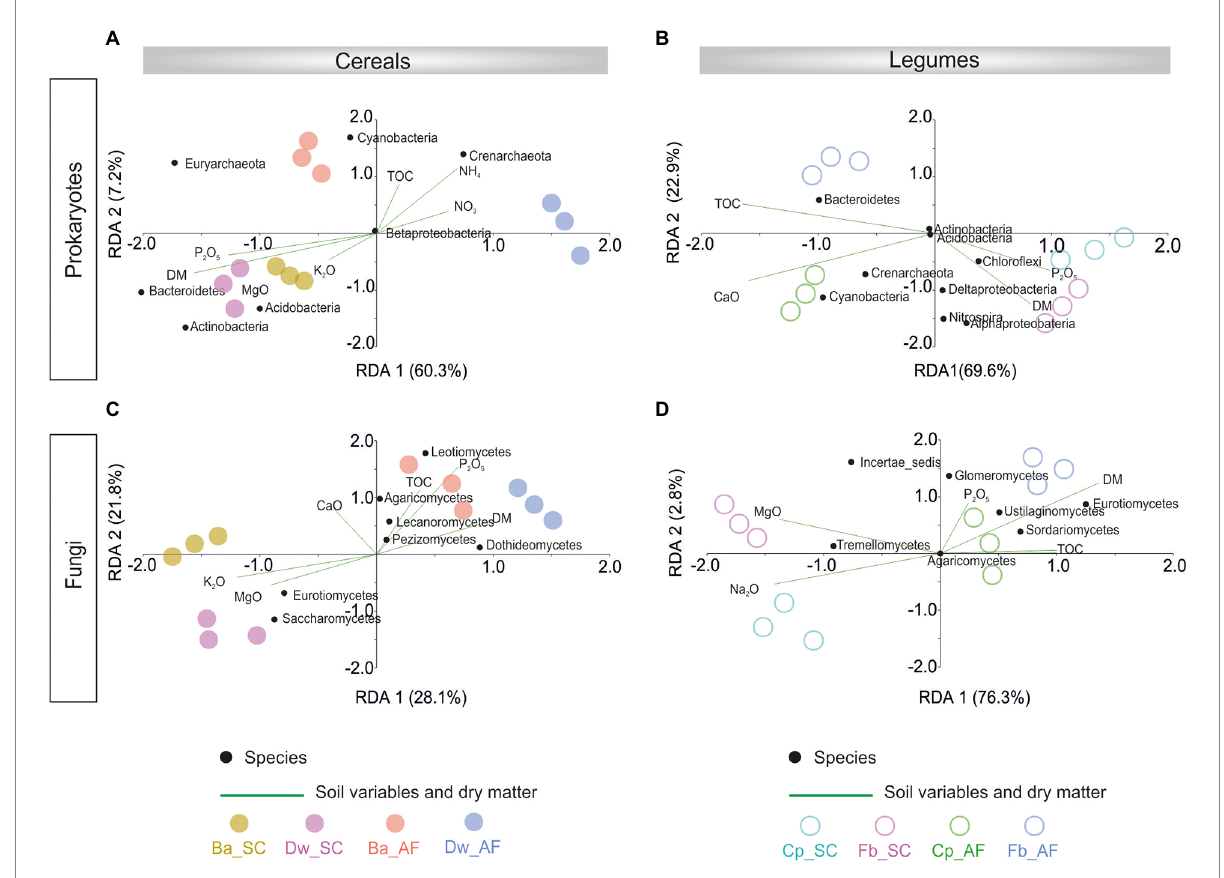
FIGURE 5 Redundancy analysis (RDA) showing variation in abundant rhizosphere prokaryotes phylum/class in cereals (A) and legumes (B) crops and abundant rhizosphere fungi in cereals (C) and legume (D) explained by crops dry matter (DM) production and soil physicochemical parameters. Significant influencing factors derived from Nonparametric Spearman correlations are shown ( p < 0.05). AF, agroforestry system; SC, full sun cropping; Ba, barley; Dw, durum wheat; Cp, chickpea; Fb, Faba bean; TOC, total organic